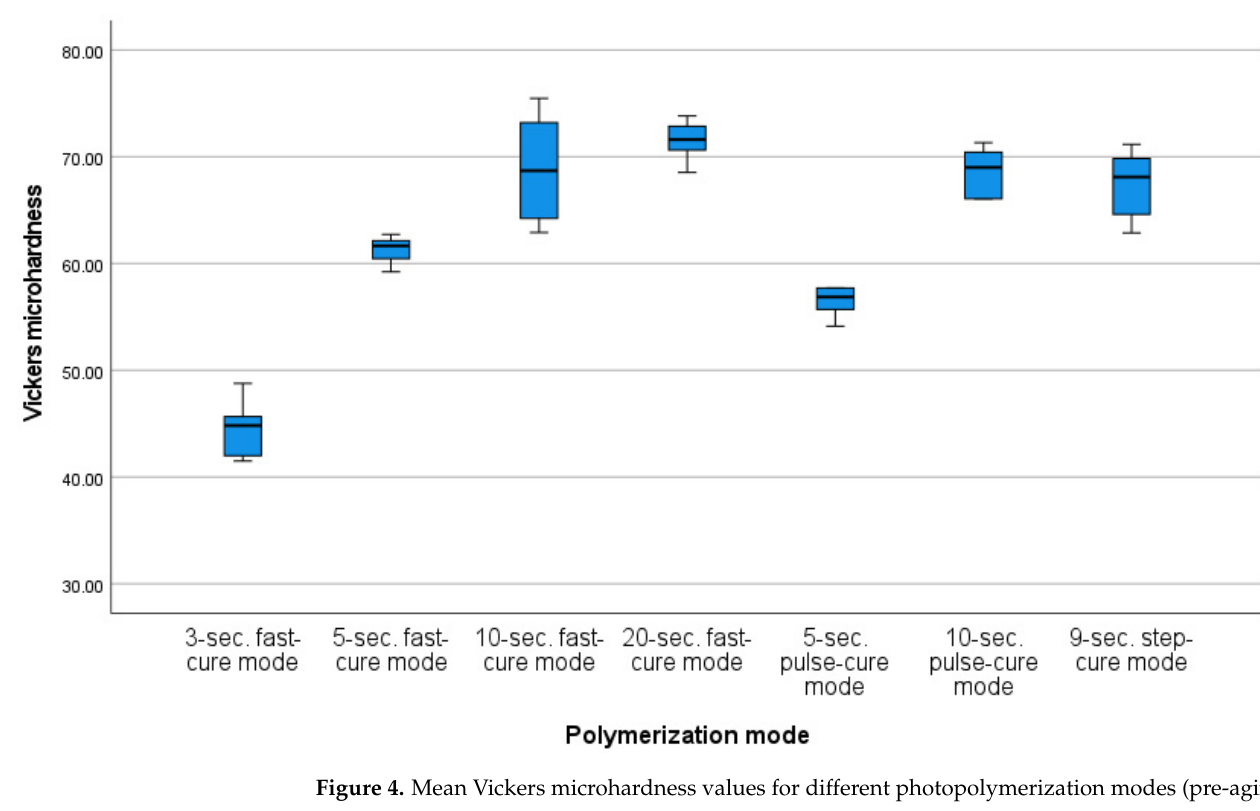
Figure 4. Mean Vickers microhardness values for different photopolymerization modes (pre-aging).